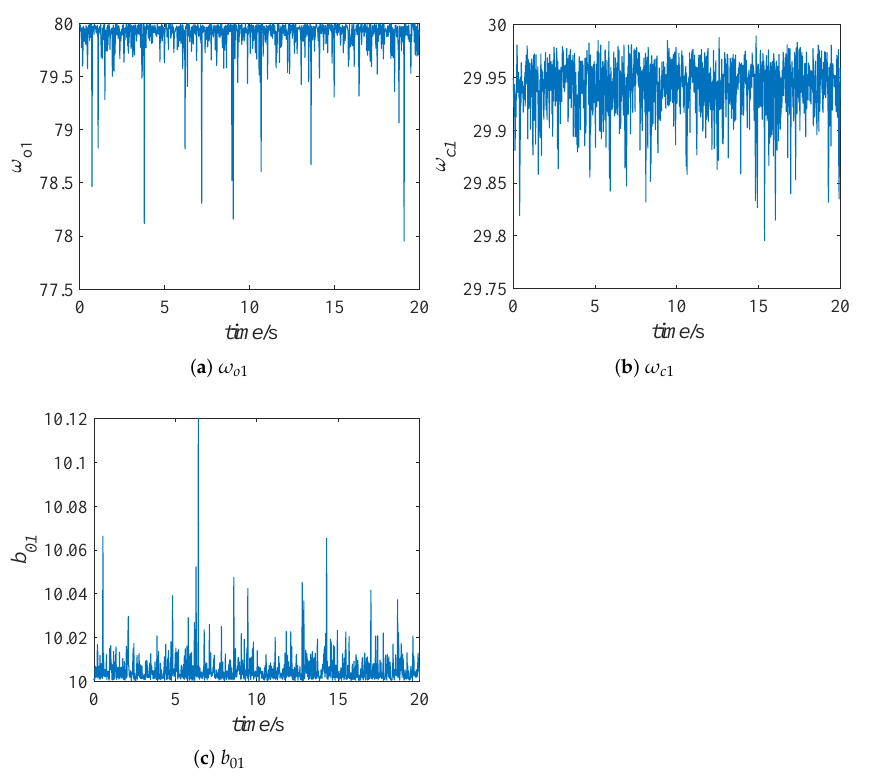
Figure 7. Controller parameters of thermal power plant.